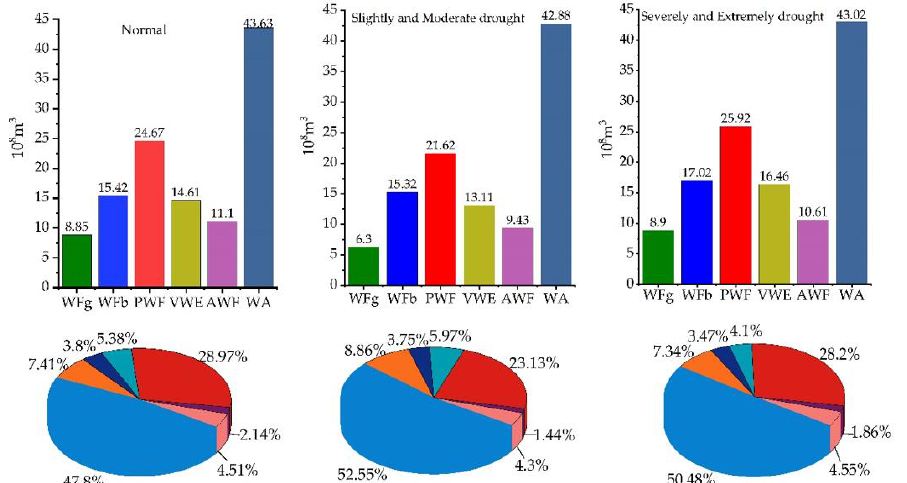
Figure 7. Changes in WF and WA under three drought conditions (Normal, Slightly and Moderate drought, Severely and Extremely drought) in Hotan (The pie chart legend is the same as Figure 4).